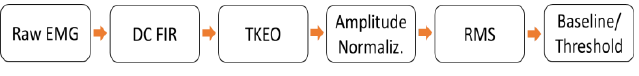
Figure 4. Raw and Teager-Kaiser Energy Operator (TKEO) EMG signal, on the same time and amplitude